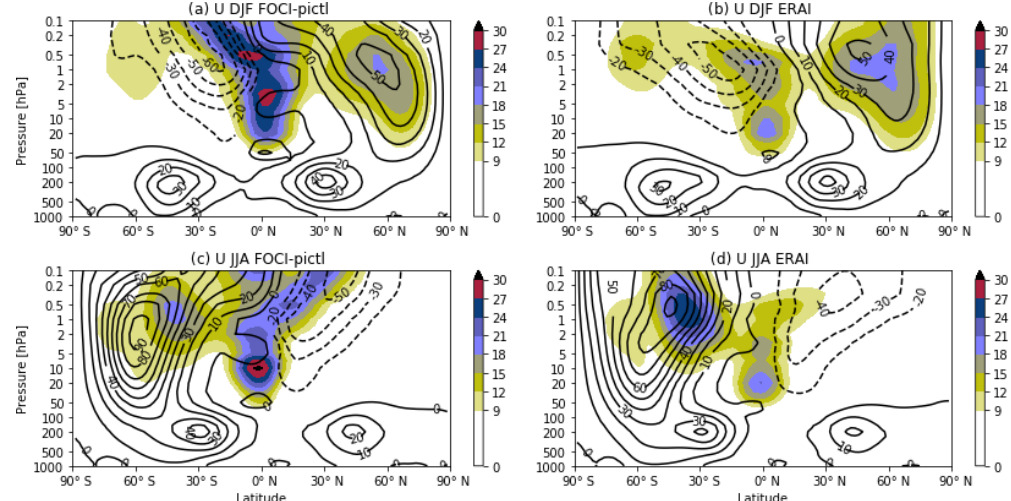
Figure 5. Zonal mean zonal wind climatology from FOCI-piCtl for (a) DJF and (c) JJA, and ERA-Interim reanalysis climatology (1979– 2017) for (b) DJF and (d) JJA; contour interval is 10ms − 1 ; shading indicates the zonal mean zonal wind standard deviation in ms − 1